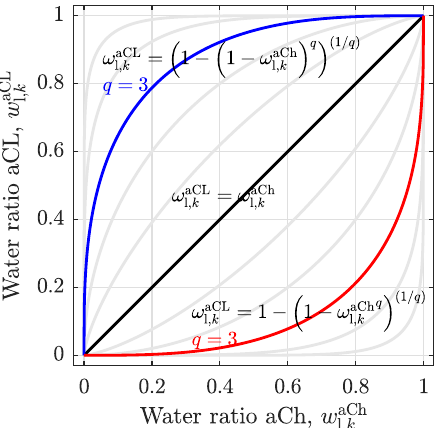
Figure 3. Coupling functions of the liquid phase ratio in the anode channel, ω aCh liquid phase volume ratio on the anode catalyst layer surface, ω aCL